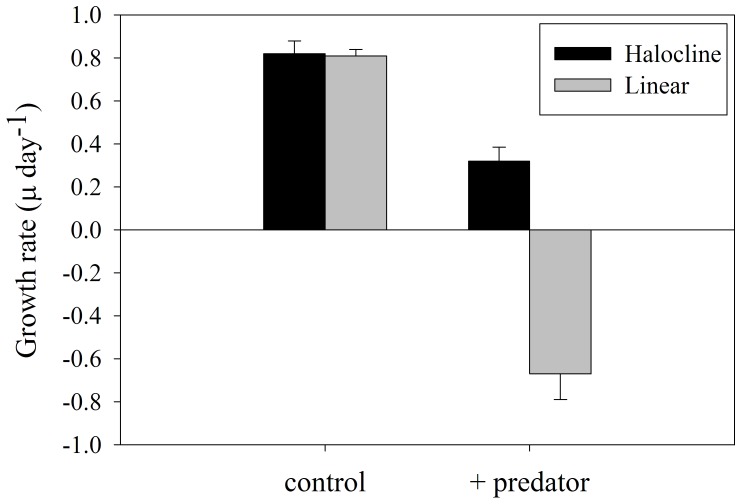
Salinity structure impact on phytoplankton growth rate.Population growth rate (µ day−1) of H. akashiwo either in a halocline (black) or linear (gray) salinity gradient in the phytoplankton only control (left) and in the presence of the predator (right). Phytoplankton fleeing behaviors and availability of a low salinity refuge effectively reduced predator-prey encounter rates and resulted in significant growth of H. akashiwo in the presence of the predator.